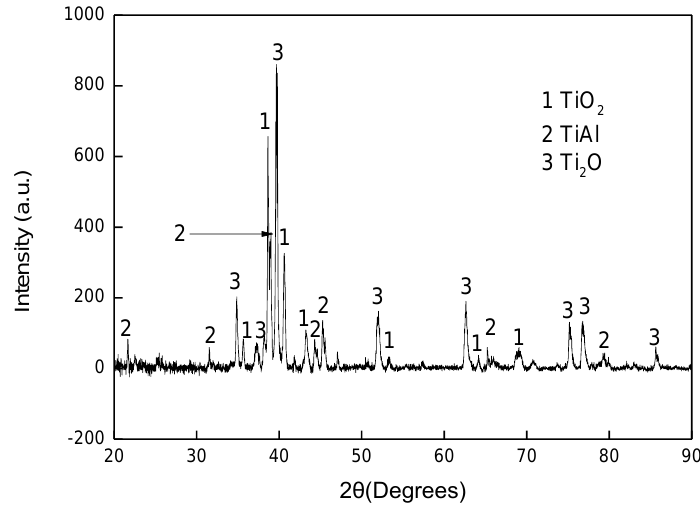
Figure 7. XRD pattern for cross-sectioned Ti heated up to 1000 °C.